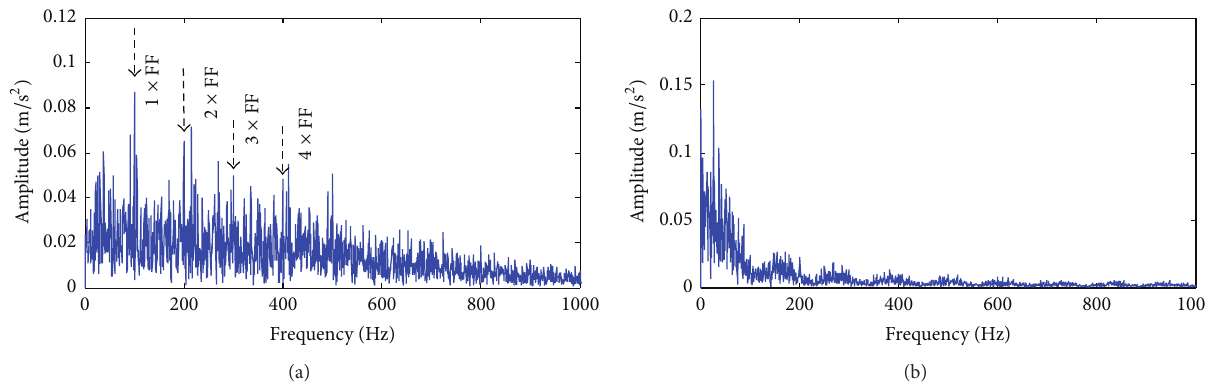
Figure 14: (a) Frequency spectrum of filtered signal by first length of SE; (b) frequency spectrum of filtered signal by ninth length of